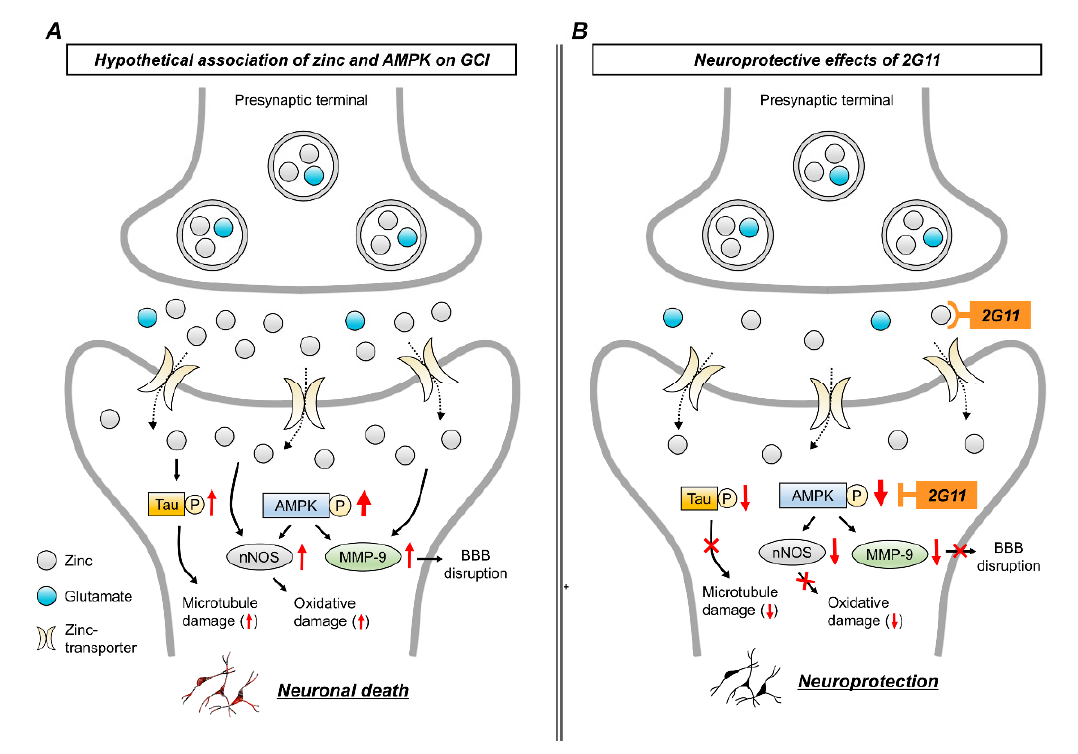
Figure 7. Proposed cascades of 2G11 effects on GCI-induced neuronal death. ( A ) Schematic illustra- tion describing the possible cascades through which GCI induces neuronal damage via zinc overload and AMPK phosphorylation. ( B ) Neuroprotective effects of 2G11 on GCI: 2G11 chelates zinc and reduces AMPK phosphorylation, thus preventing hippocampal neuronal death after GCI.